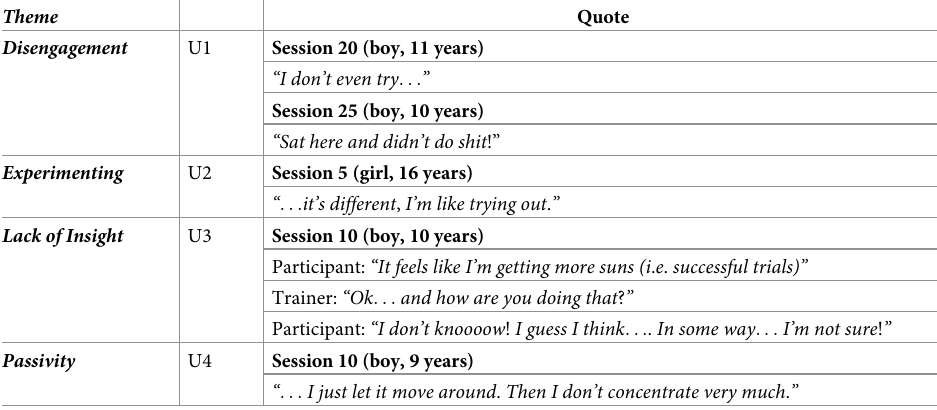
Table 5. Quotes of unspecified strategies during slow cortical potential